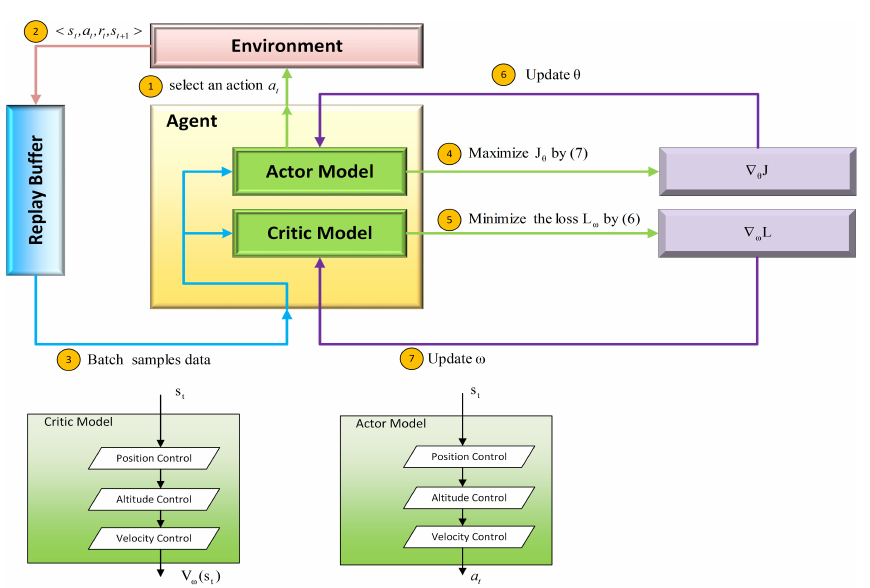
Figure 7. Framework of the planning